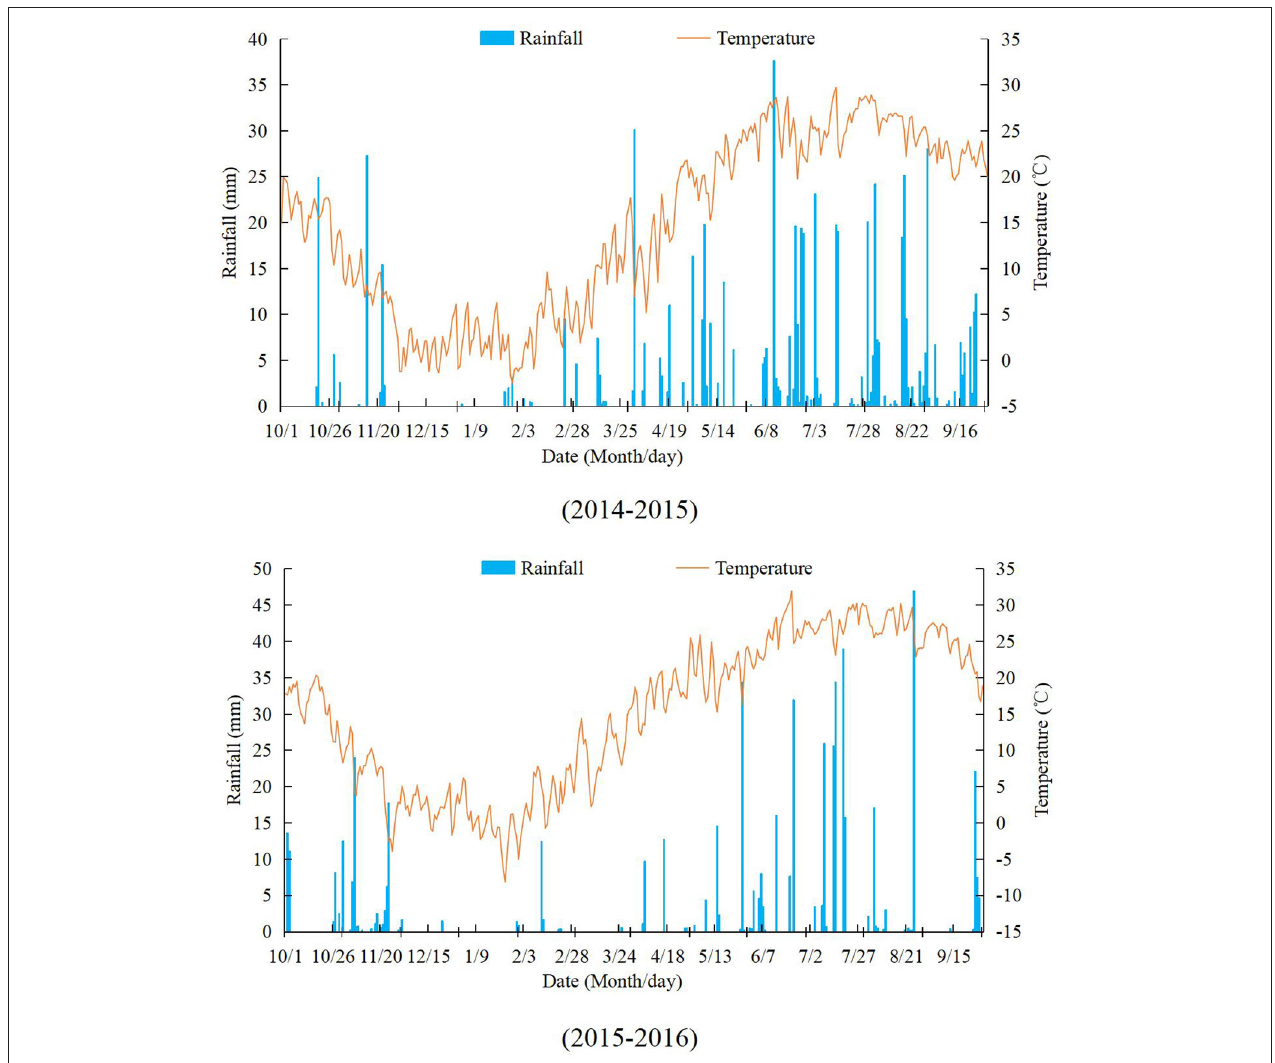
FIGURE 1 | Distribution of rainfall and temperature from 2014 to